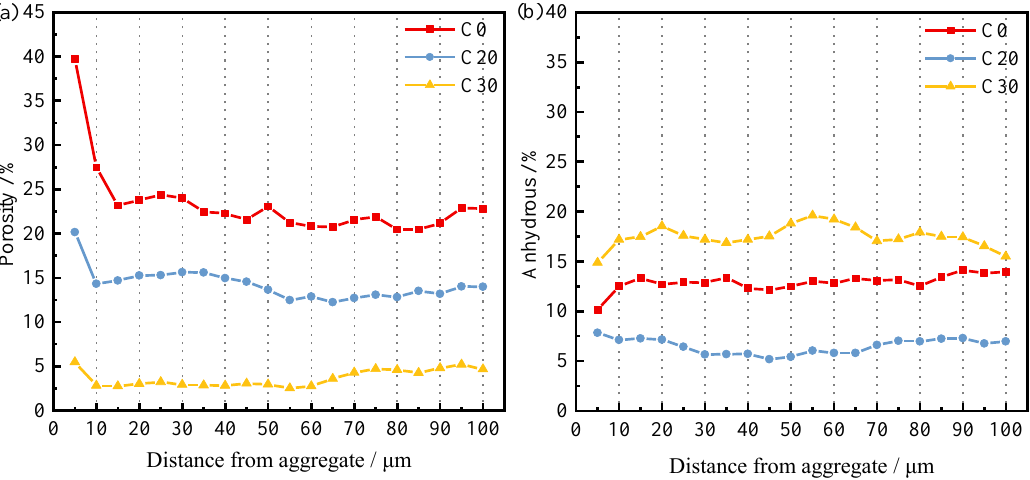
Figure 12. Effect of IOT grinding time on (a) Porosity, and (b) Anhydrous profiles of 28-d concrete.